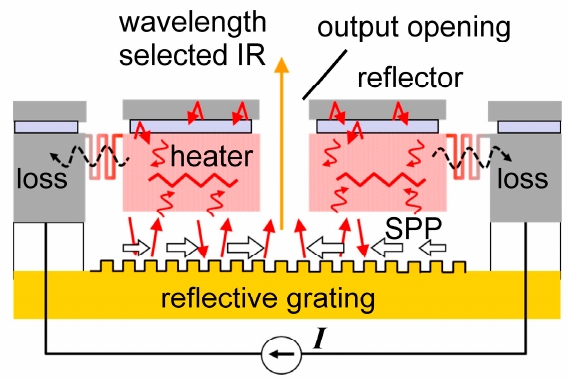
Figure 1. Schematic drawing of the indirect wavelength-selective thermal emitter and the energy flows.